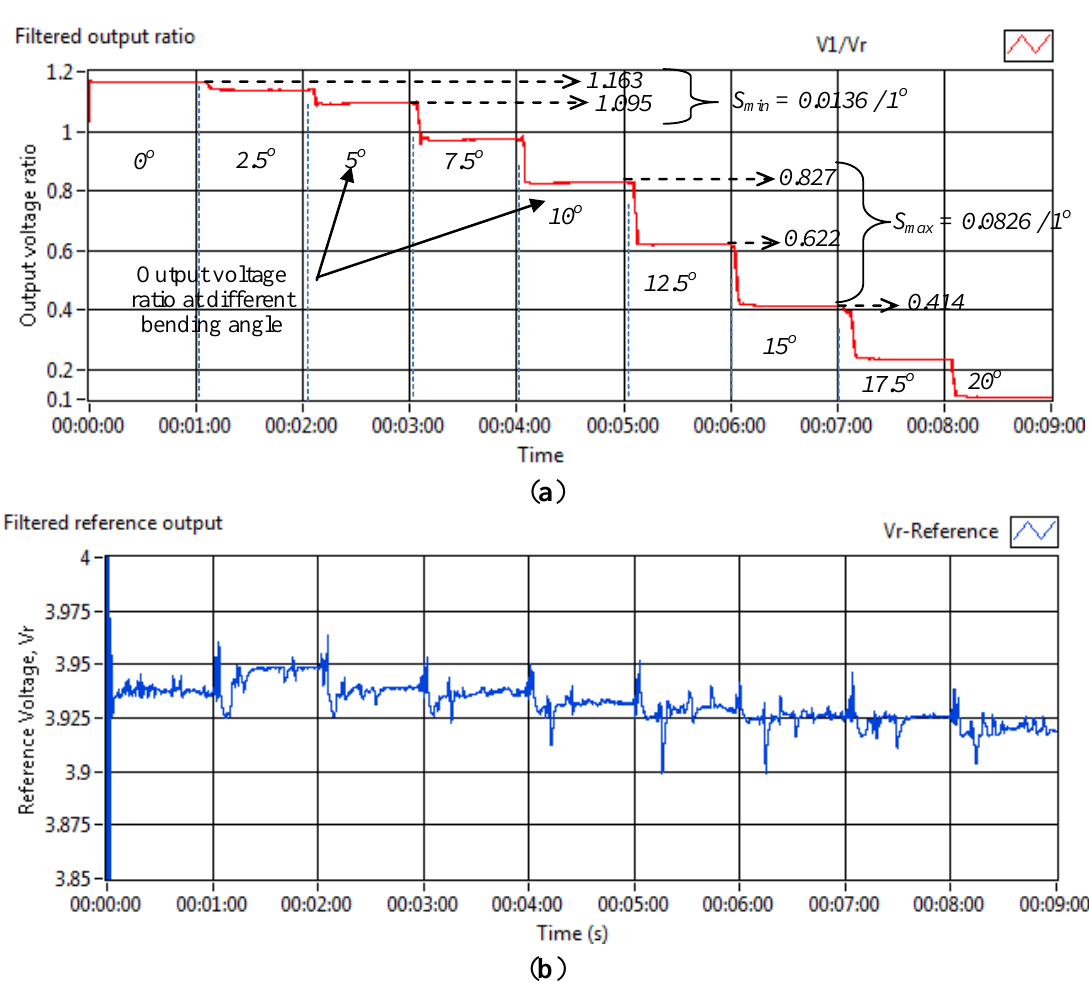
Figure 5. Bending assessment—( a ) output voltage ratio; ( b ) reference